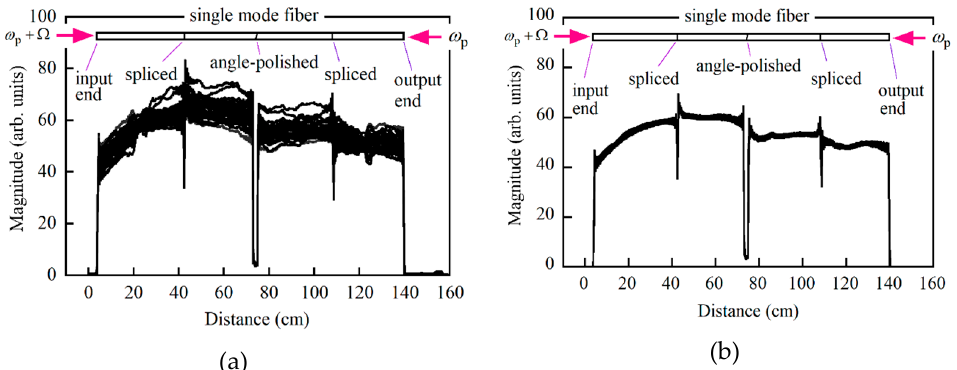
Figure 2. Overwritten reflectograms from a 1.35 m long optical fiber that were obtained by 30 frequency sweeps of a tunable laser when the pump LD was driven with ( a ) current source A and ( b ) current source B. The up-conversion frequency was 10.861 GHz.